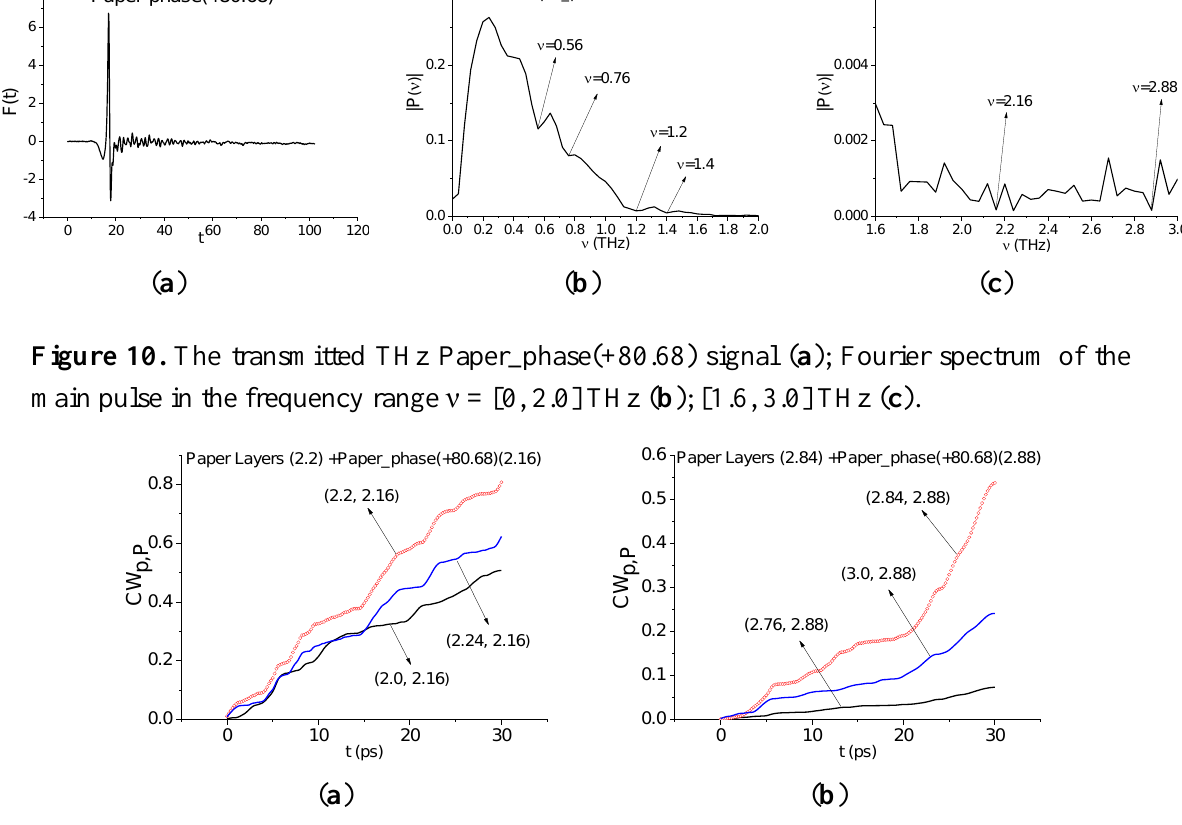
Figure 11. Integral characteristics CW p , P ( t n ) detecting the frequencies ν = 2.2 THz ( a ); 2.84 THz ( b ) for Paper Layers signal using the Paper_Phase(+80.68) signal as a standard